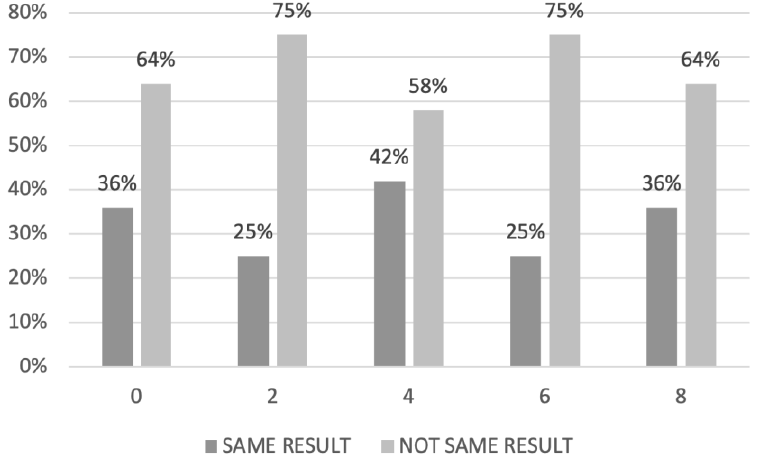
Figure 1. Agreement between laparoscopic and radiological predictive index (PI) in women who underwent primary debulking surgery.